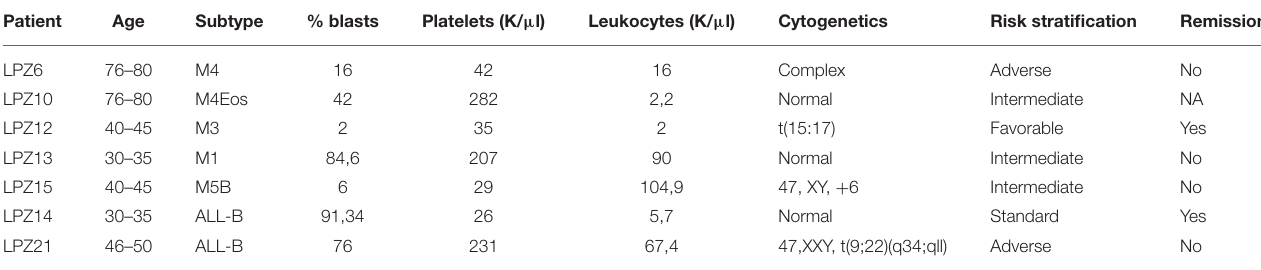
TABLE 1 | Diagnostic information of patients with acute leukemia.